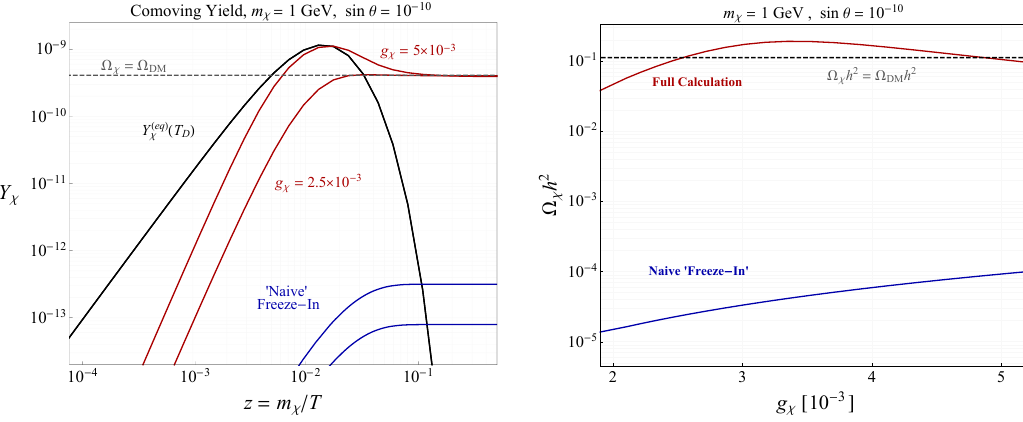
Figure 4 . Left: comoving yield Y (cid:31) = n (cid:31) ( T D ) =s ( T ) for two representative g (cid:31) , which yield the observed DM abundance. Note that for both g (cid:31) < 2 : 5 10 (cid:0) 3 and g (cid:31) > 5 10 (cid:0) 3 the comoving (cid:2) (cid:2) yield is diminished. For reference, the blue curves at the bottom of the plot are the ‘naive’ freeze in result obtained by ignoring the (cid:31); (cid:30) dynamics in the hidden sector and merely integrating the SM source term in the Boltzmann equation from eq. (1.2). Right: Total (cid:31) abundance for (cid:12)xed mass and coupling plotted alongside di(cid:11)erent choices of DM self coupling g (cid:31) . Note that the production history for the two points where the red curve intersects the dashed line are represented on the left